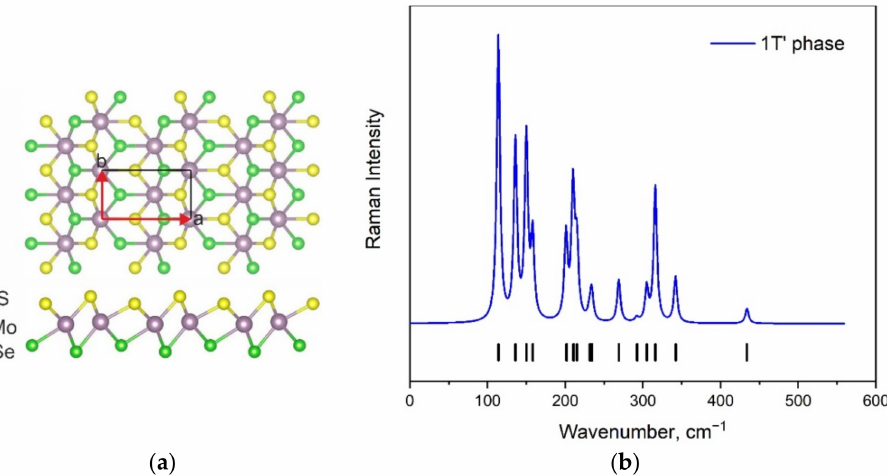
Figure 5. The structure of 1T’-MoSSe modification ( a ). Simulated Raman spectrum of phase ( b ). Calculated wavenumbers are shown by vertical lines.